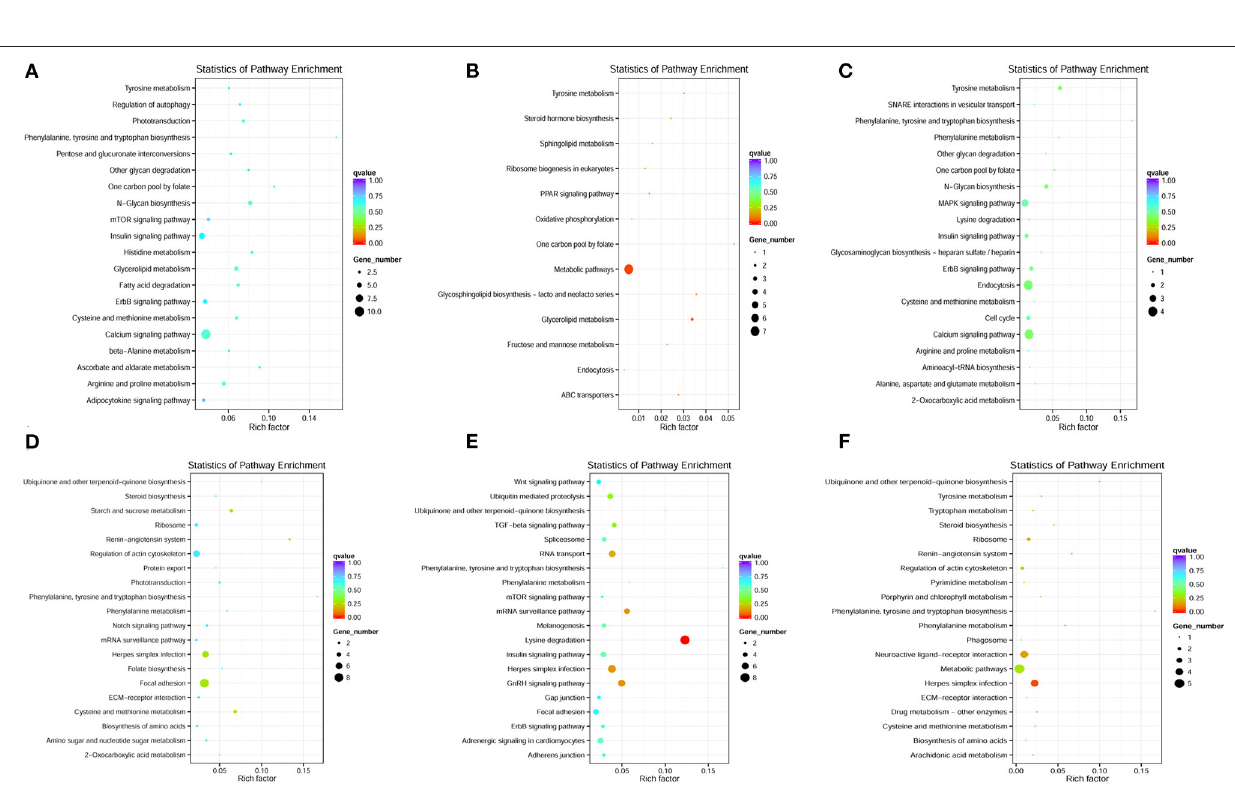
FIGURE 5 | KEGG pathway enrichment of co-located and co-expressed mRNAs. (A–C) The most significantly enriched top 20 pathways of co-located mRNAs in the H2 vs. H0, H8 vs. H0, and H12 vs. H0 comparisons, respectively. (D–F) The most significantly enriched top 20 pathways of co-expressed mRNAs in the H2 vs. H0, H8 vs. H0, and H12 vs. H0 comparisons,